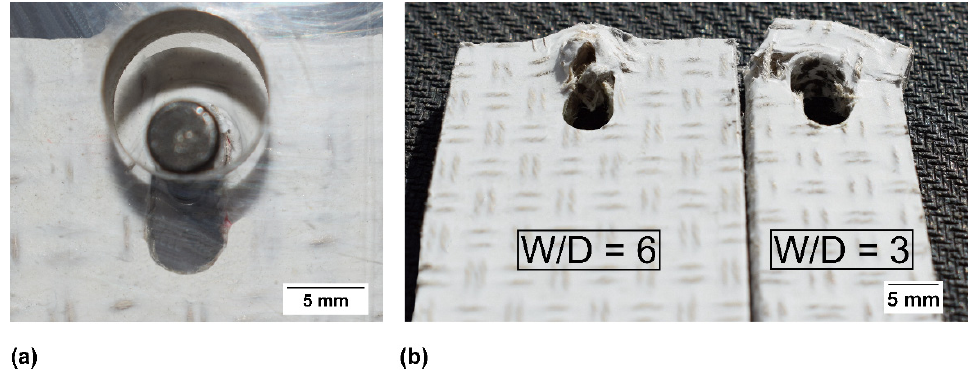
Figure 8. ( a ) Magnification of area close to the hole in the bearing tests with W/D = 6 of H1 sample type and ( b ) comparison of H1 sample tested with W/D equal to 6 and